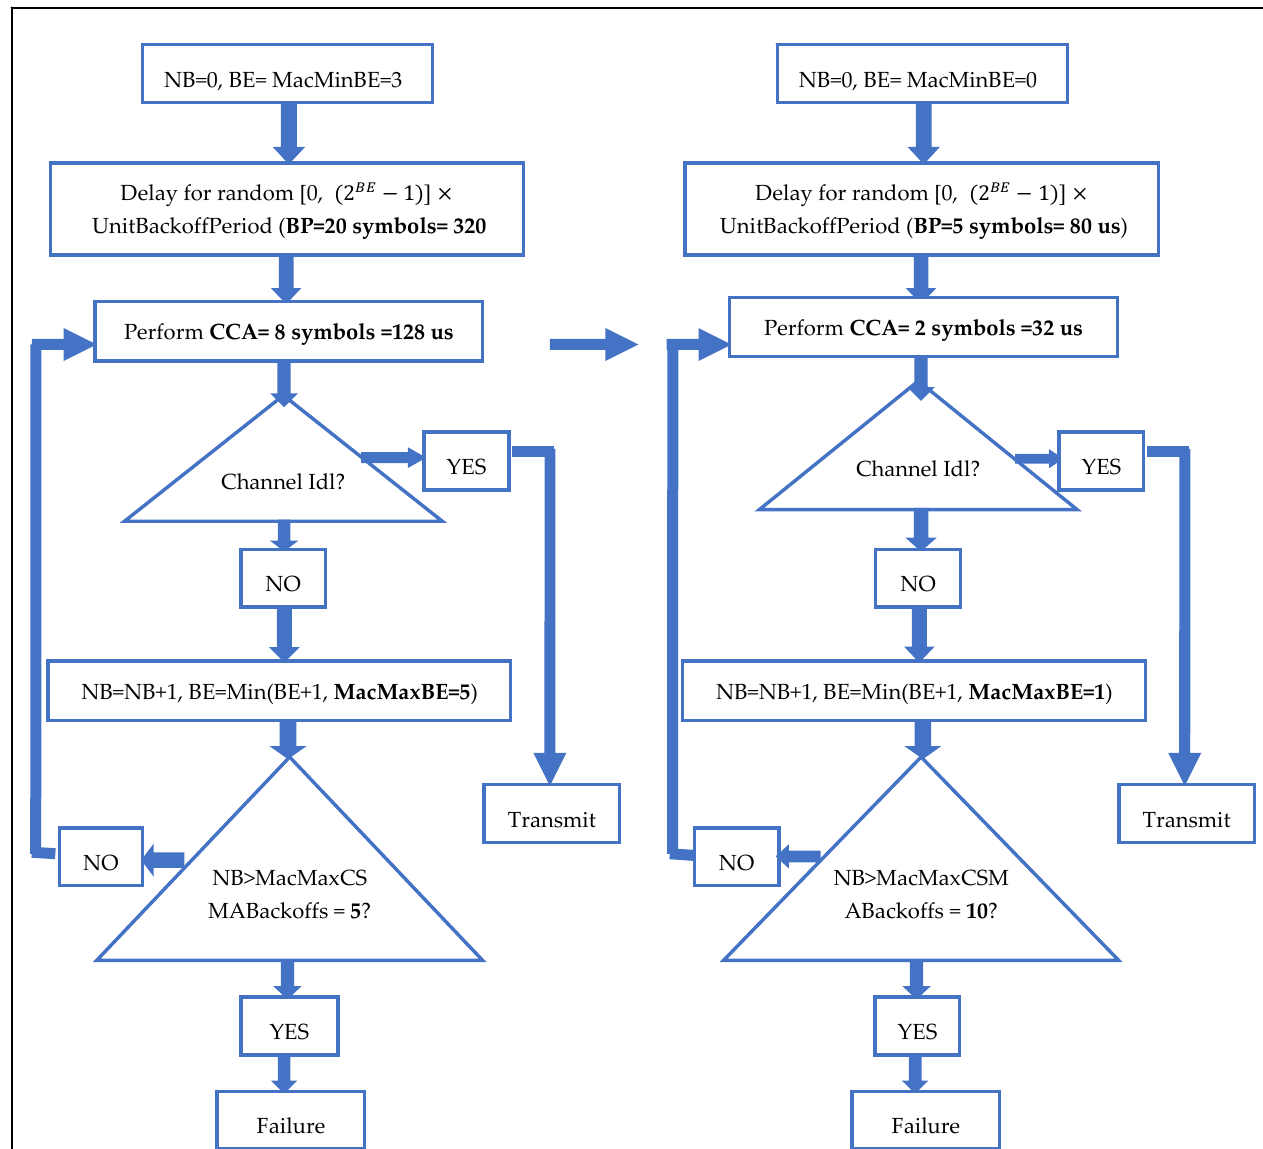
Figure 1. The difference between CSMA/CA algorithm and greedy node algorithm.